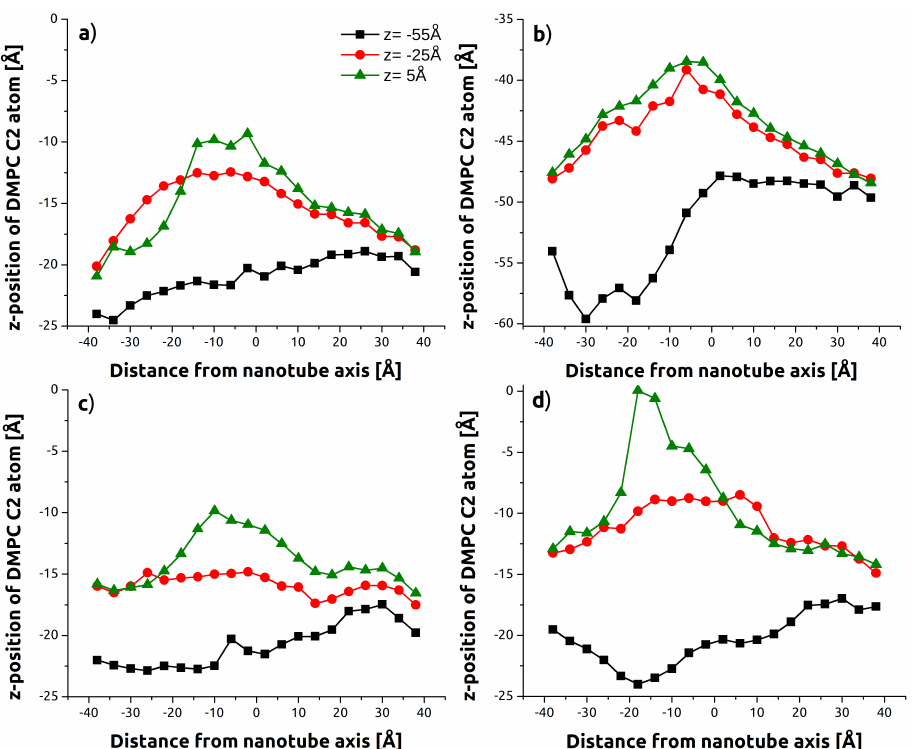
Figure 8. Sequential deflection profiles for SiCNT as illustrated by the average DMPC backbone C2 atom position to a resolution of 4 Å. ( a ) Low rate ( v = 0.5 m/s), tube-axis, upper layer; ( b ) Low rate ( v = 0.5 m/s), tube-axis, bottom layer; ( c ) High rate ( v = 2.0 m/s), tube-axis; ( d ) Low rate ( v = 0.5 m/s), z